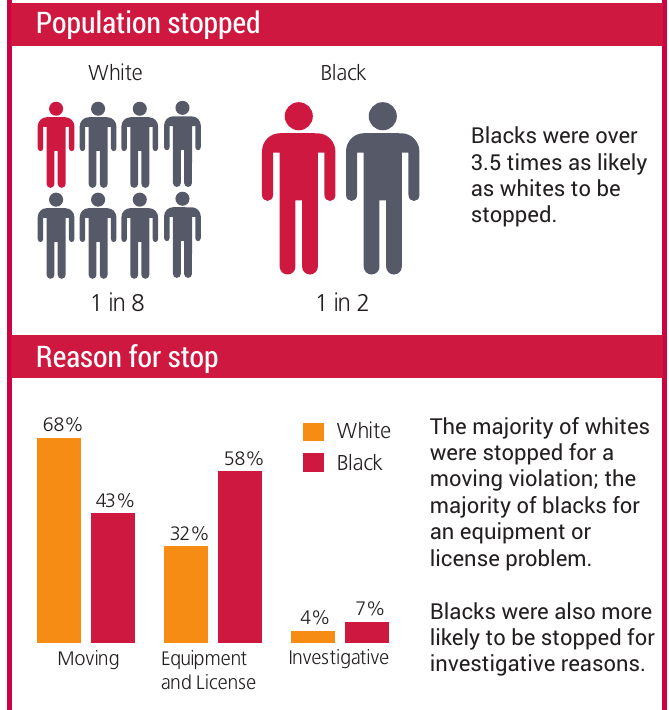
Figure 1. Ferguson traffic stops, 2013: Population stopped and reason for